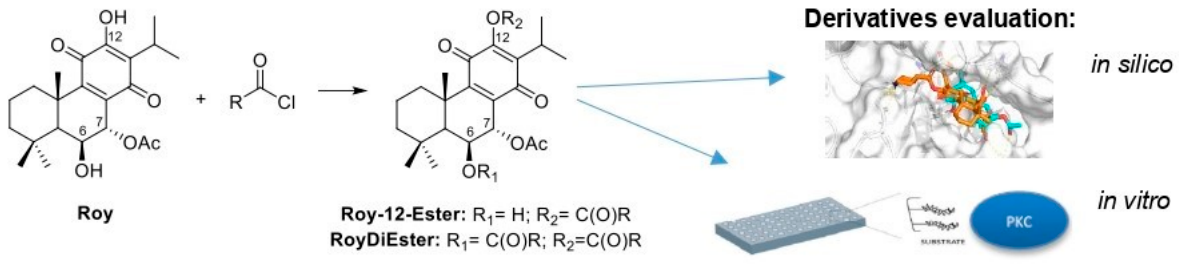
Figure 1. Preparation and evaluation of Roy